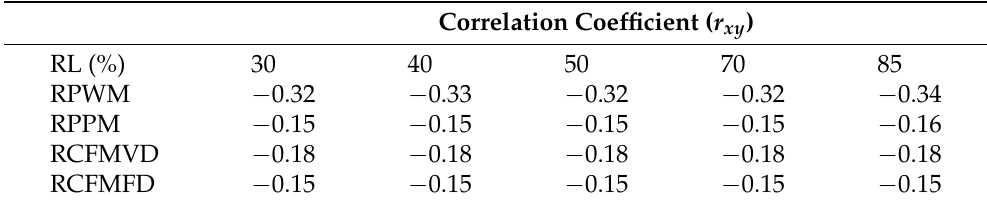
Table 8. Comparison of the correlation coefficient of switch 1 and 2 of an interleaved circuit with different randomness levels and random modulation